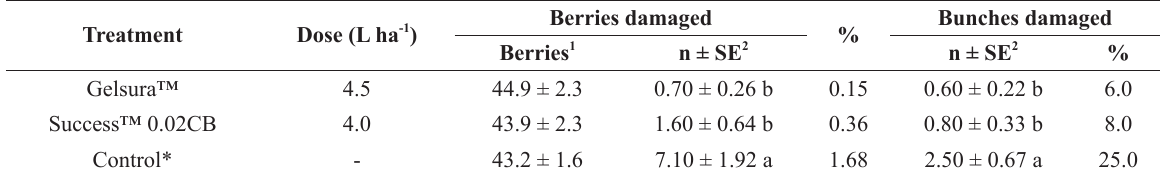
Average number (n ± standard error) and percentage (%) of berries and bunches of table grapes of the ‘Arra-15’ cultivar containing damage by Ceratitis capitata over three weeks of evaluations. Petrolina, PE (Area 2).